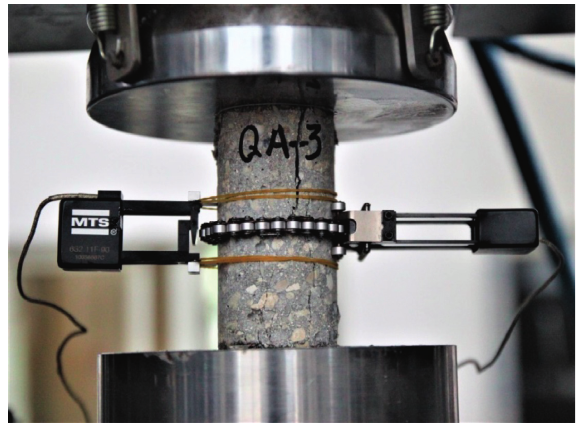
Figure 5: A specimen in the uniaxial compression tests.